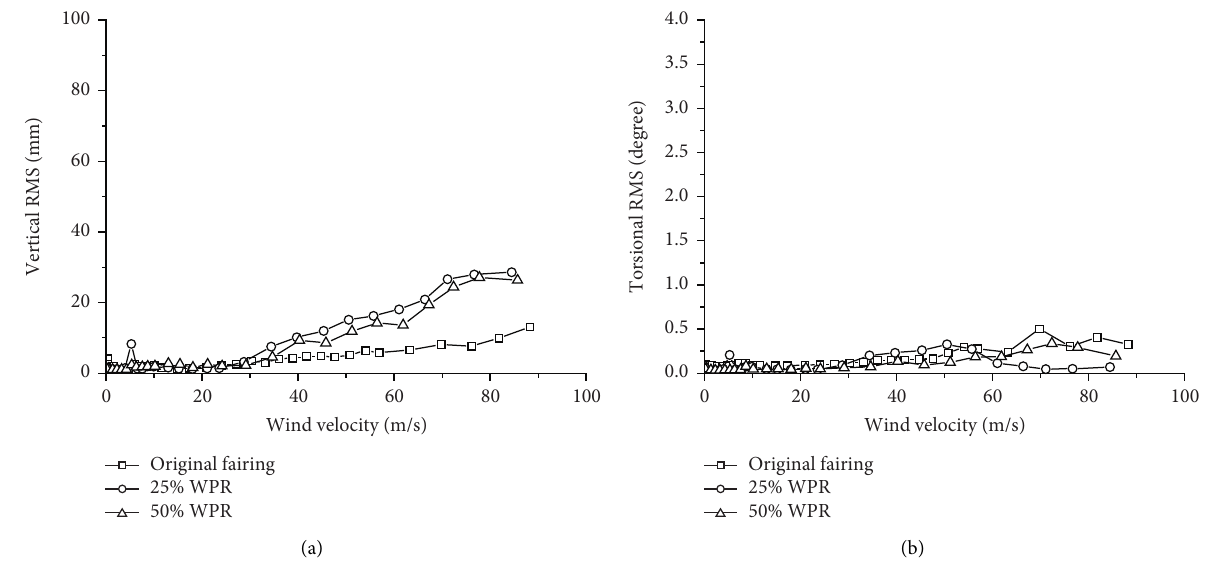
Figure 14: RMS versus wind velocity in laminar flow (attack angle 0 ° ): (a) vertical RMS; (b) torsional